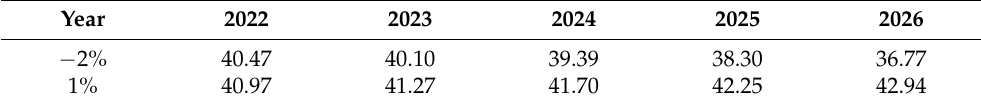
Table 8. Prediction results of water requirement with different growth rates of AVPI in Beijing.